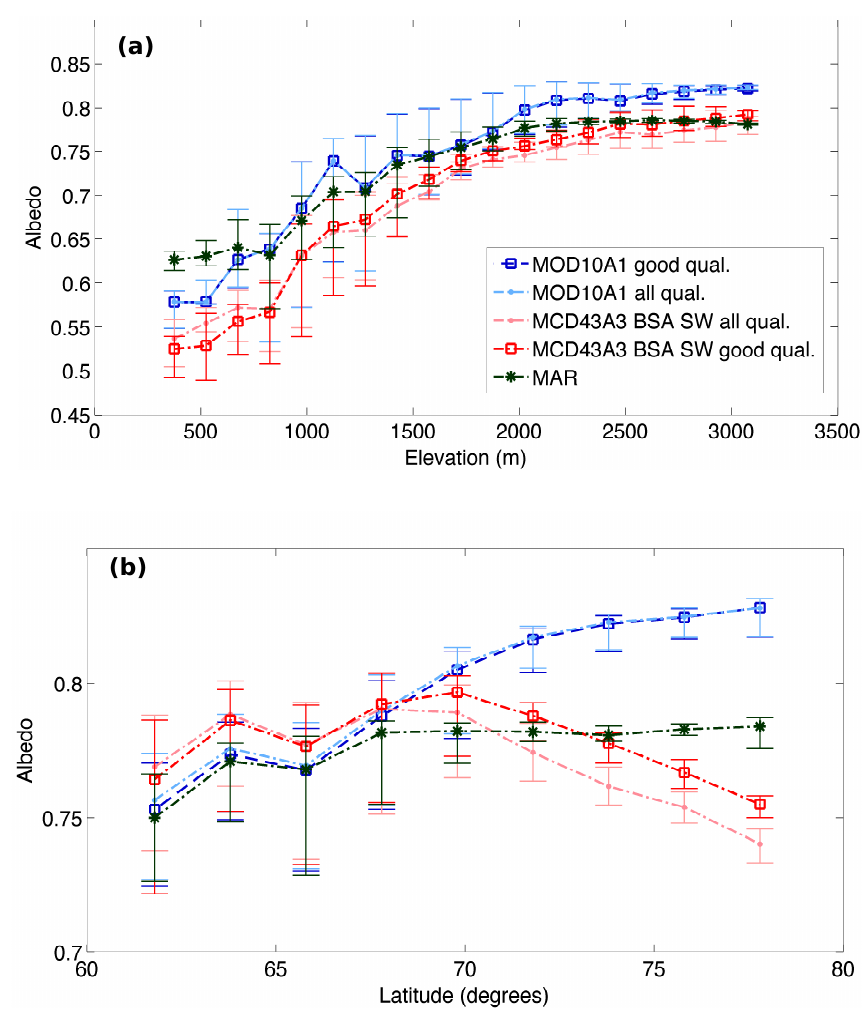
Figure 4. (a) Mean 2000–2013 JJA MOD10A1, MCD43A3 BSA SW, and MAR v3.2 clear-sky GrIS albedo (unitless) as a function of elevation divided into 150m elevation bands. Error bars indicate standard deviation within each elevation band. (b) The same as (a) but for albedo as a function of latitude, divided into 2 ◦ Latitude bands. “Good qual.” indicates results obtained by only using “good quality” MODIS data. “All qual.” indicates that all available MODIS observations have been used. Table 4. Same as Table 3, but for the average of 16-day data for all in situ stations within each region. MCD43A3 MAR Locations MOD10A1 BSA